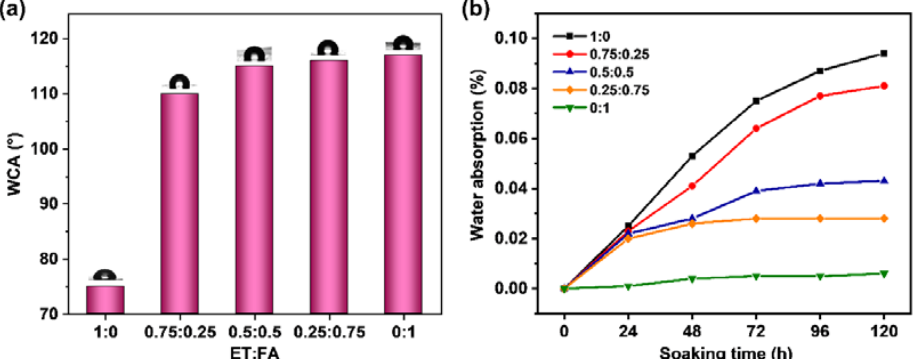
Figure 3. ( a ) Water drop contact angle (WCA) and ( b ) water absorption of waterproof coatings with different molar proportions of